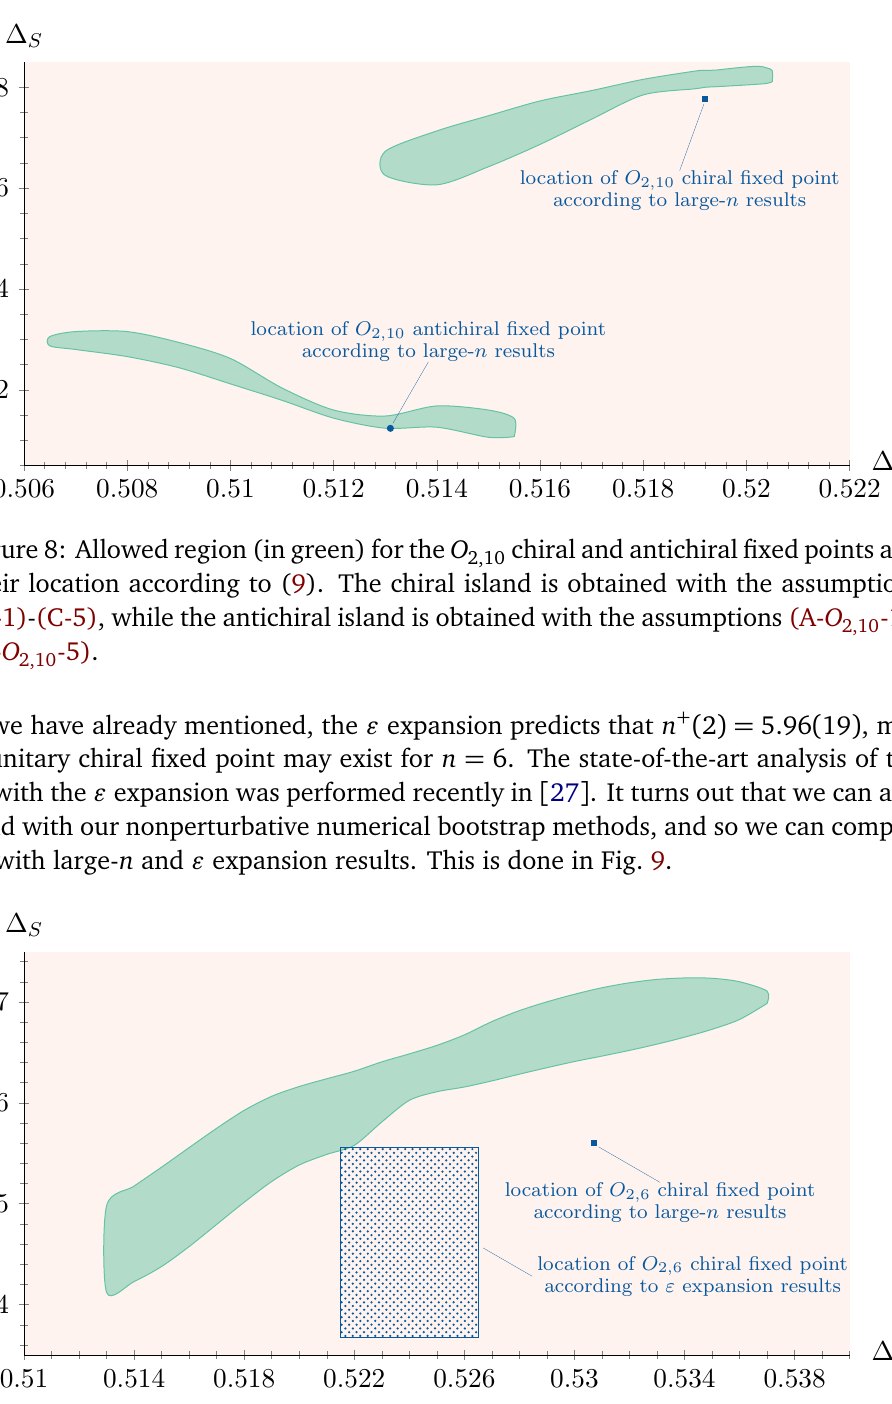
chiral fixed point and its location 2,6 X bound in Fig. 2,6